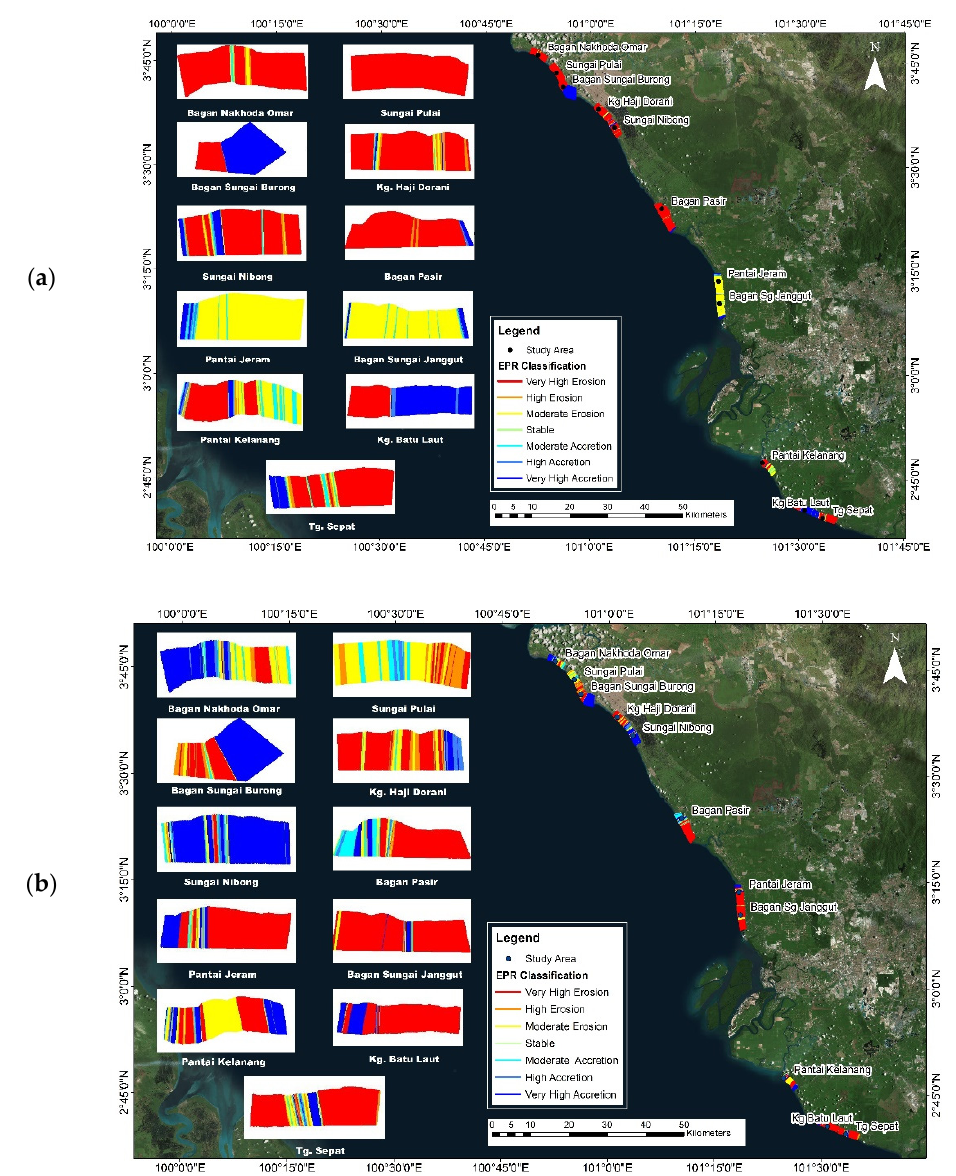
Figure 6. Shoreline change along the study area from ( a ) 1993–2004 and ( b )